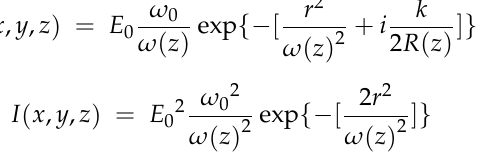
where, ω ( z ) is the beam radius (i.e., ω ( z ) = ω 0 of ω ( z ) at z = 0, which is called the light waist radius, r is the distance between a point in space ( x , y , z ) and the light source; and k is the wave number (i.e., k = 2 π / λ ). Figure 3 shows the light intensity distribution of the Gaussian beam with a beam waist radius of 20 mm, wavelength λ = 532 nm, and z = 0. It can be seen that the light spot is a regular circle, and the light spot is at the